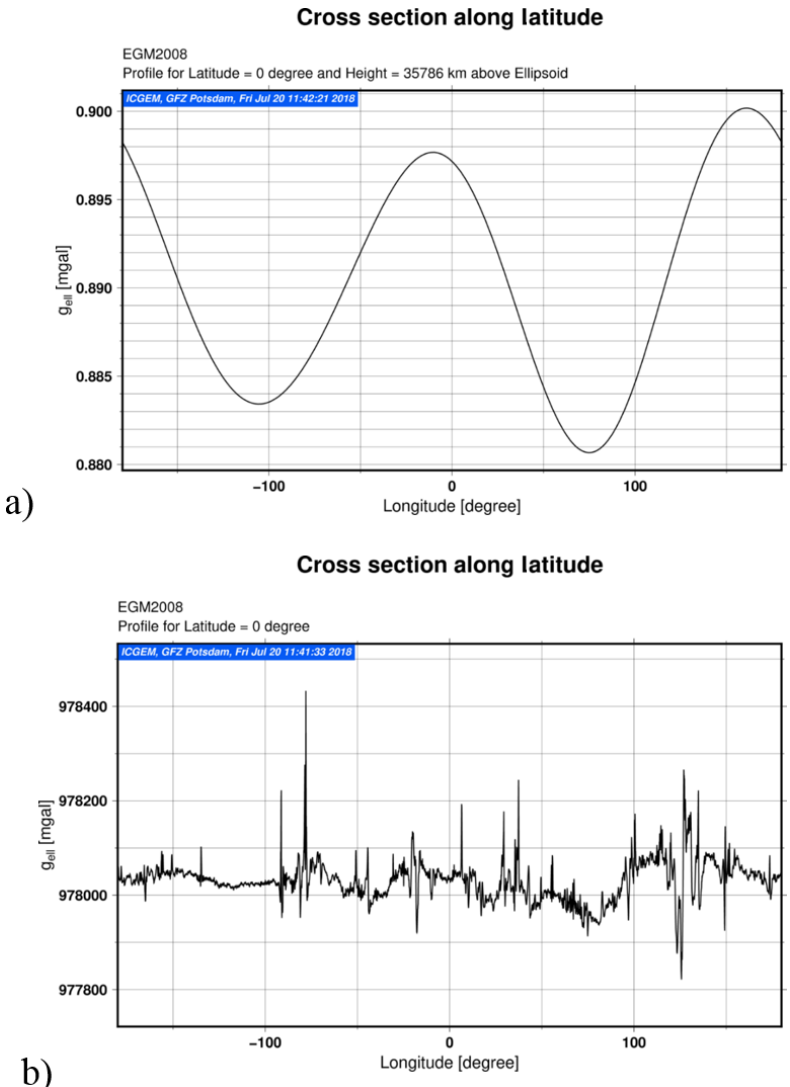
Figure A2. Cross section calculation of gravity field functionals along latitude. The figures below show a cross section along the latitude of (a) gravity of a potential geostationary satellite at an altitude of approximately 36000km and (b) gravity on the Earth’s surface along the